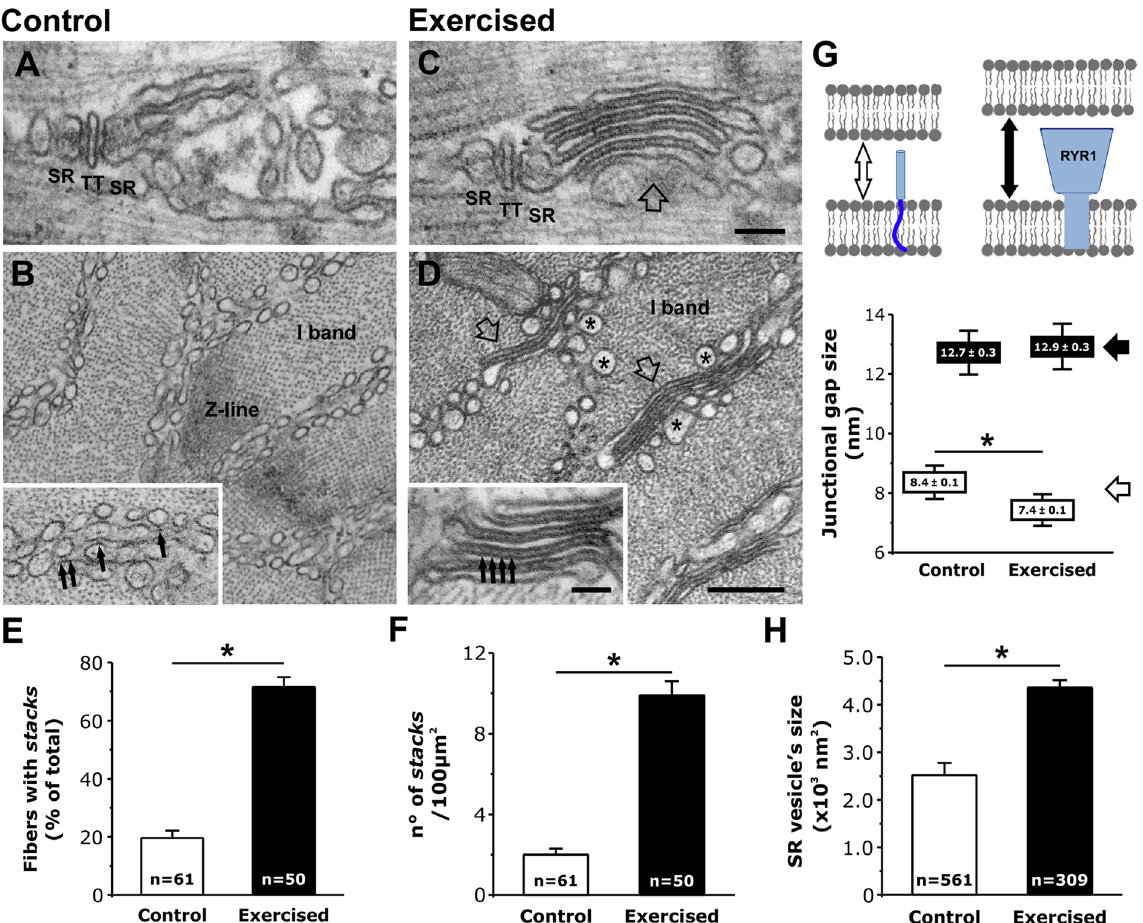
Figure 1. Following exercise, membranes at the I band rearrange into stacks of flat-cisternae. ( A – D ) Longitudinal ( A and C ) and cross ( B and D ) EM sections in proximity of the I bands. Empty arrows in ( C and D ) point to newly formed stacks of flat-cisternae; arrows in insets point to strands between SR vesicles ( B ) and flat-cisternae ( D ). ( E and F ) Incidence of stacks. Sample size: control, 3 mice; exercised, 3 mice . ( G ) Junctional gap size in membrane stacks (empty arrows) and in triads (black arrows) measured as shown in the cartoon. Samples size: control, 3 mice/76 measurements/21 stacks analyzed; exercised, 3 mice/119 measurements/34 stacks analyzed . ( H ) Average size of SR vesicles at the I band (some larger ones are marked by asterisks in panel D). Sample size: control, 3 mice/561 measurements; exercised, 3 mice/309 measurements . Data are shown as mean ± SEM; * p < 0.01. Numbers in bars (n) indicate the number of fibers analyzed ( E and F ) and the number of SR vesicles measured ( H ). Scale bars: ( A and C ) (and insets in B and D ), 0.1 μ m; ( B ) and ( D ), 0.2 μ m.